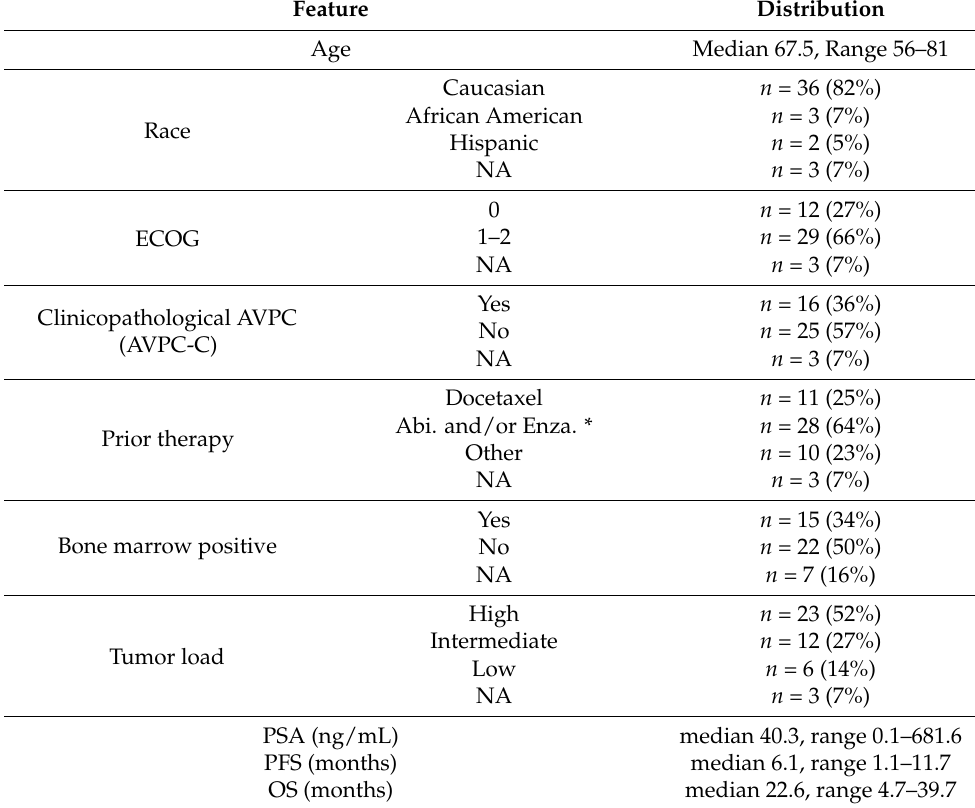
Table 1. Clinical